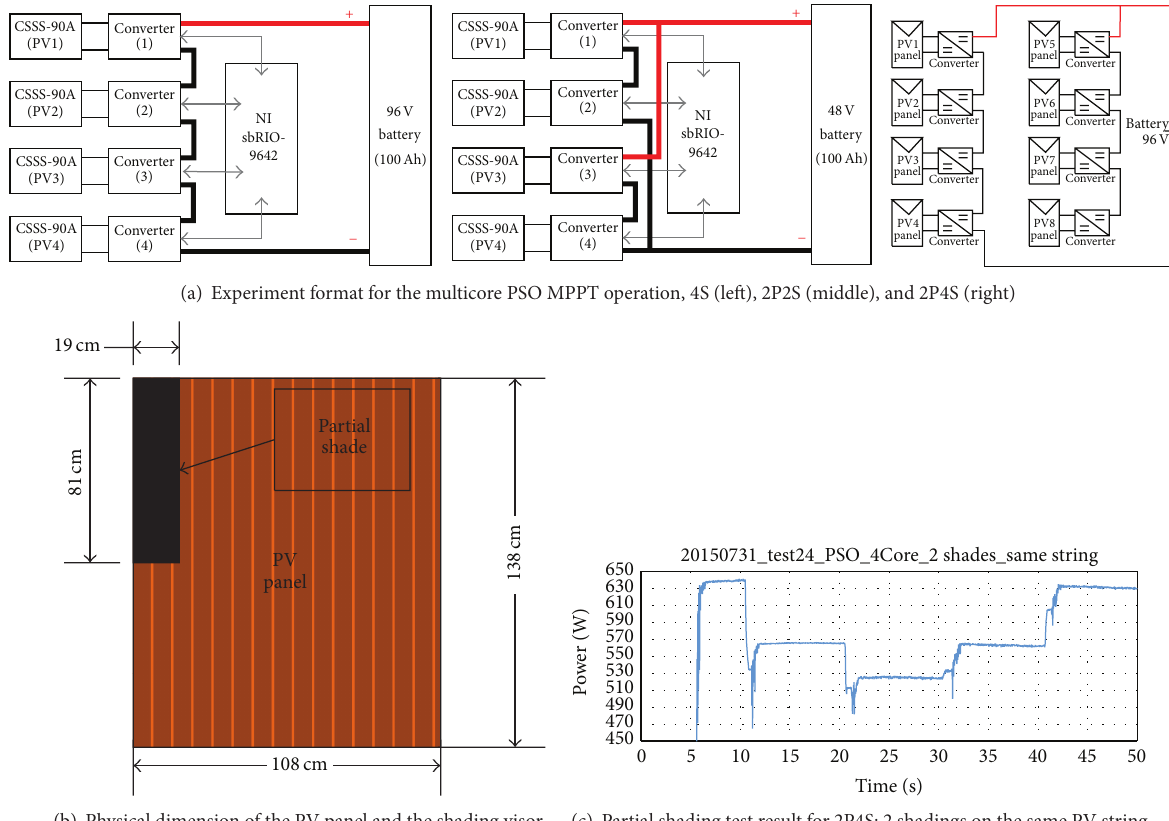
(c) Partial shading test result for 2P4S: 2 shadings on the same PV string Figure 18: (a) Schematic arrangement for the PV system in 4S, 2P2S, and 2P4S; (b) dimension of the PV panel and the shading visor; (c) a test result showing partial shading effect.